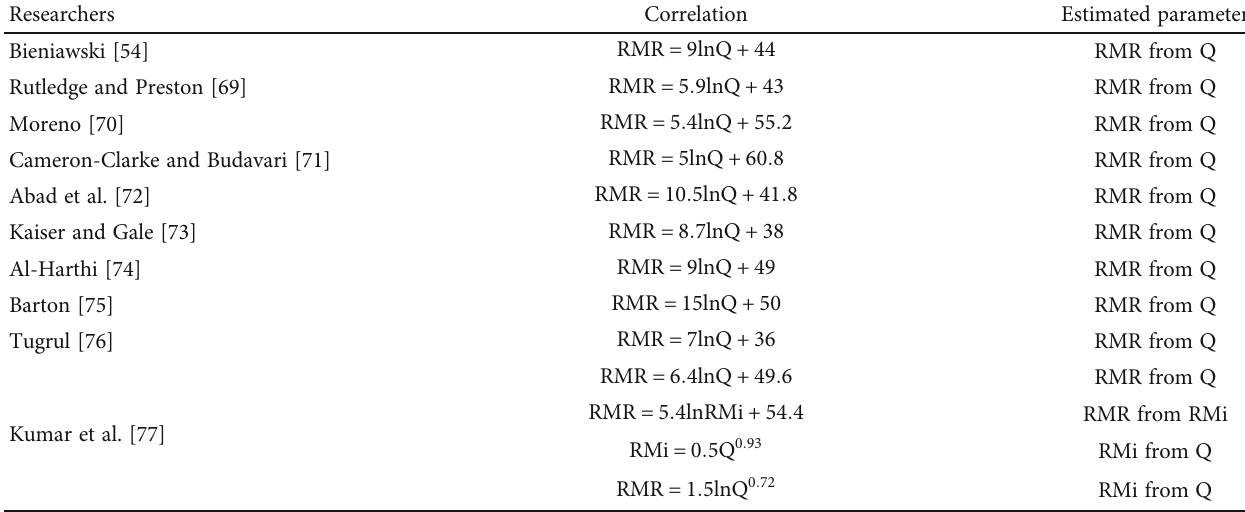
Table 2: Comparison of various correlation among the rock mass classi fi cation [4].